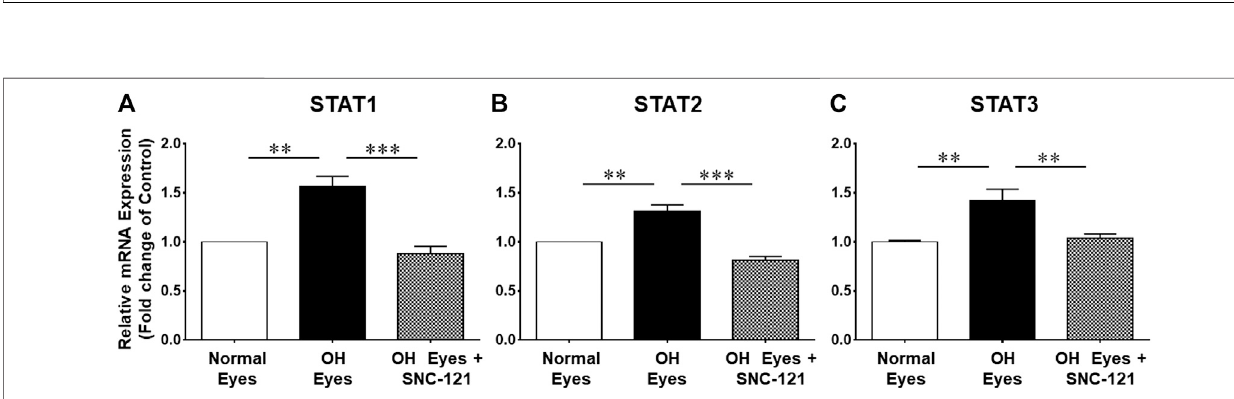
Frontiers in Pharmacology |